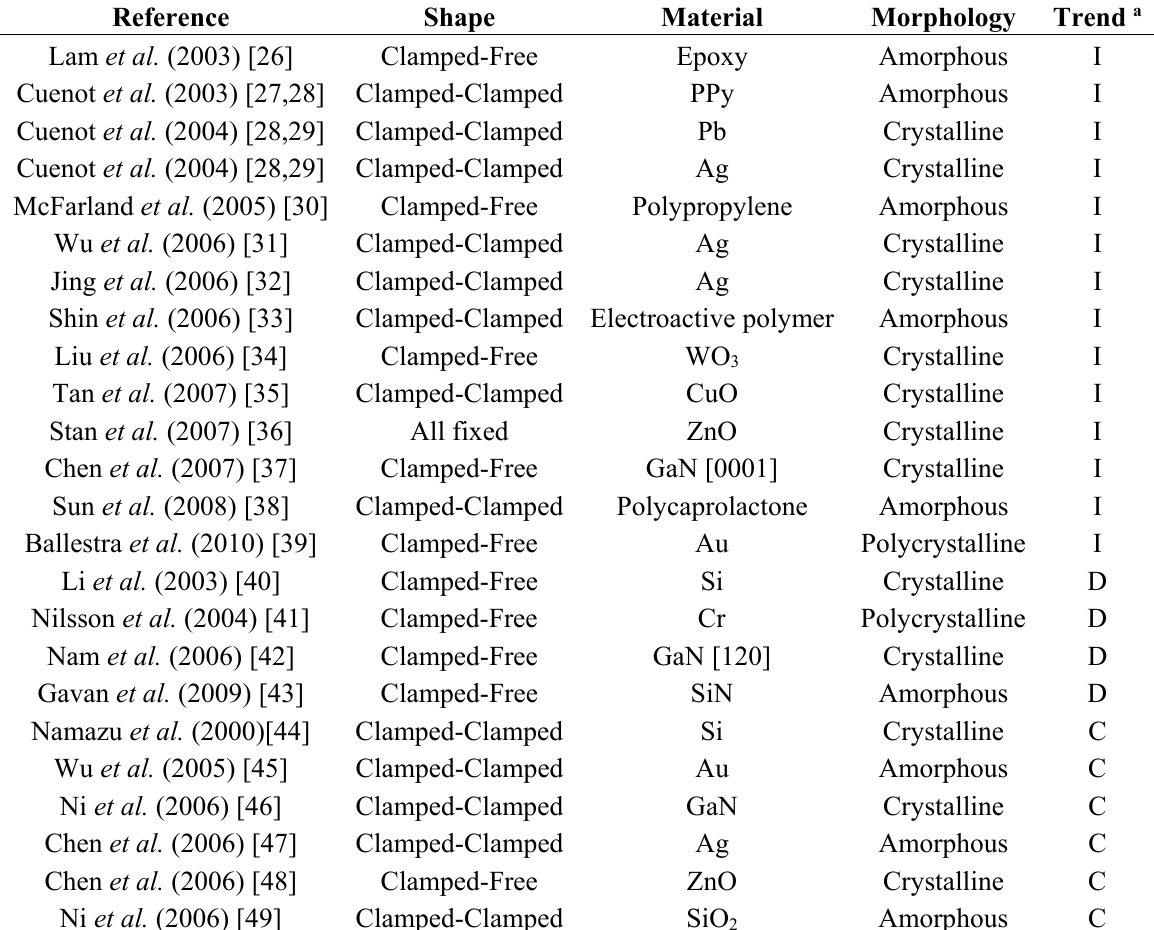
Table 1. Size dependency in micro/nano